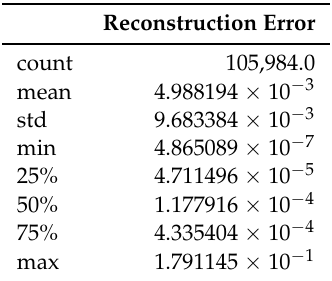
Table 2. Statistical breakdown of the reconstruction